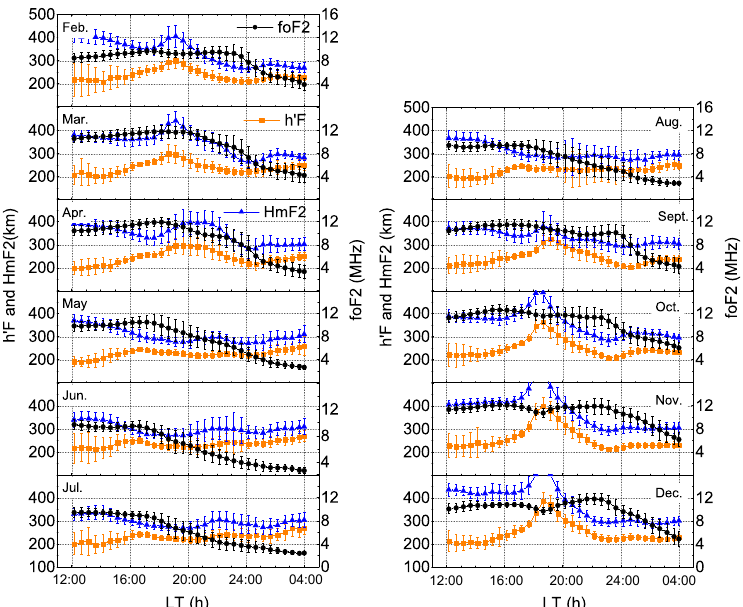
Figure 6. Monthly average of the minimum virtual height of the F region ( h (cid:48) F – orange square), the critical frequency of F2 region ( fo F2 – black circle) and the height maximum of the F2 region ( hm F2 – blue triangle). LT is UT −